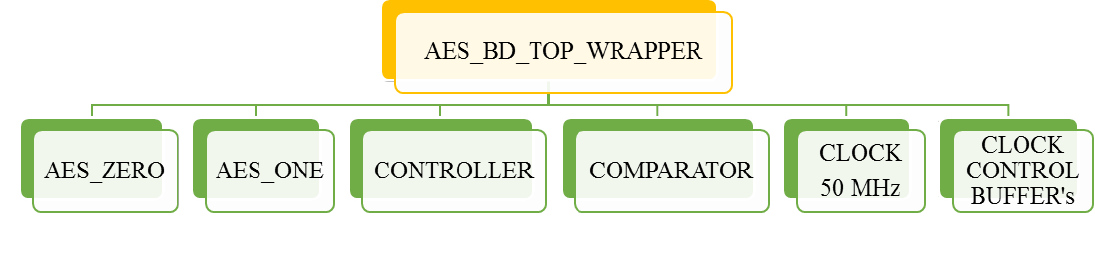
Figure 4. AES-256-based IDF Design Hierarchy.